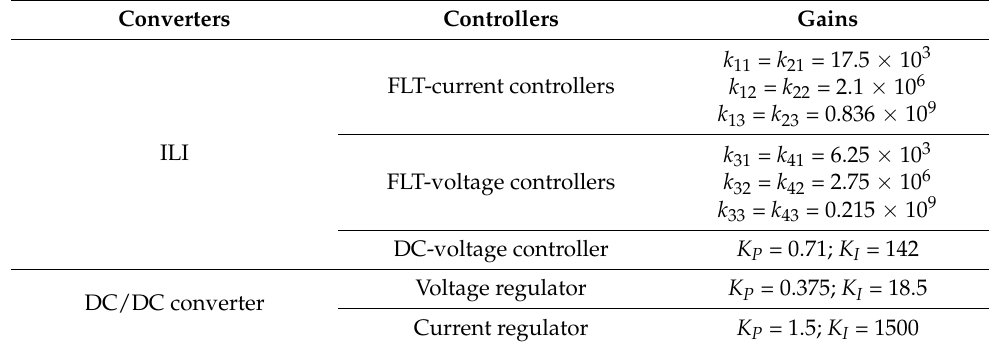
Table 2. Controller